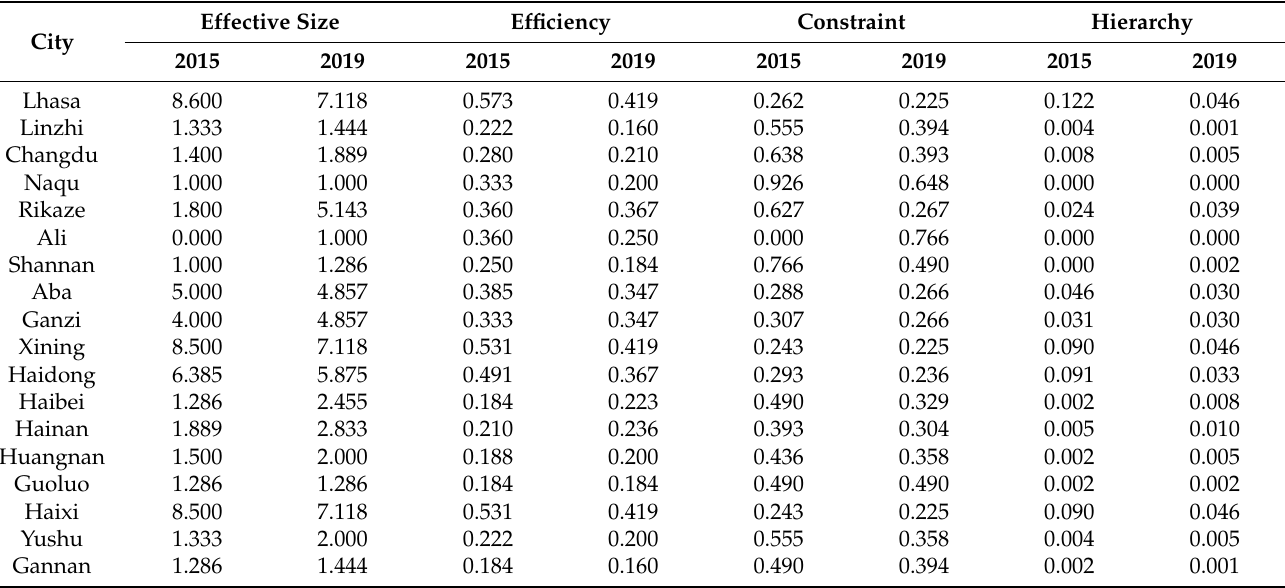
Table 3. The structural hole indicators.